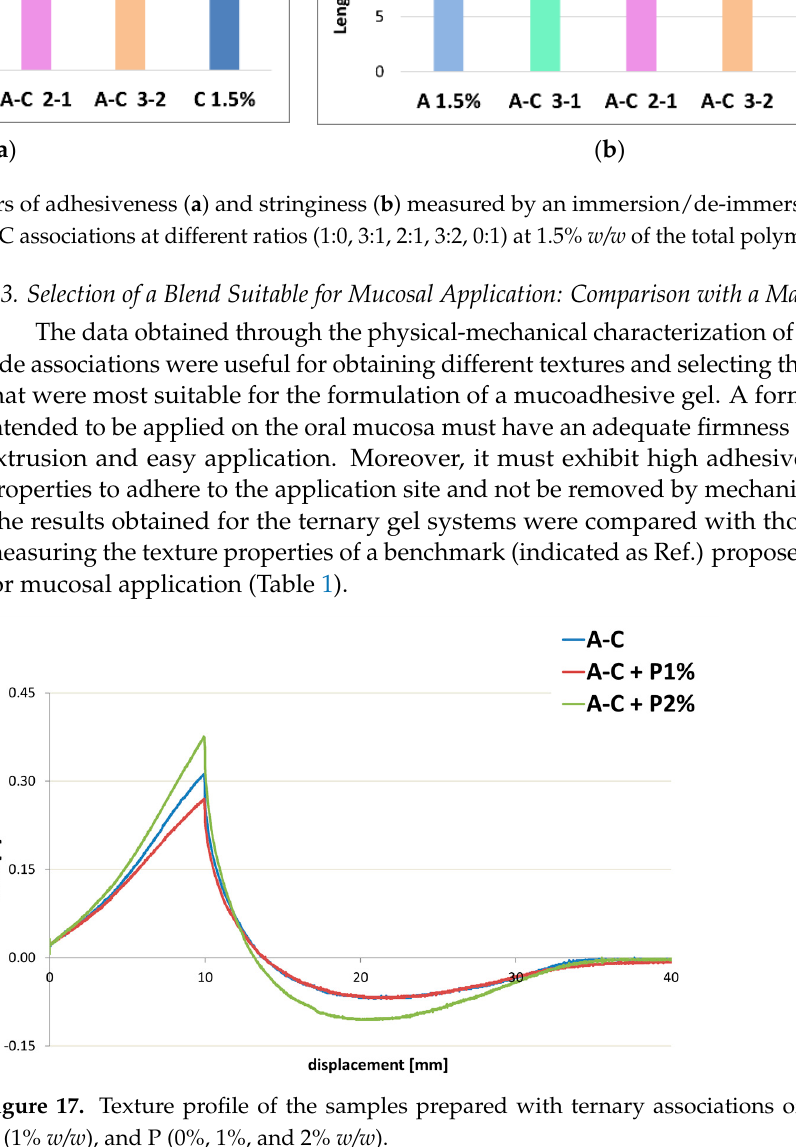
Figure 17. Texture profile of the samples prepared with ternary associations of A (1.25% w/w ), C (1% w/w ), and P (0%, 1%, and 2% w/w ), and of the reference product (Ref.).